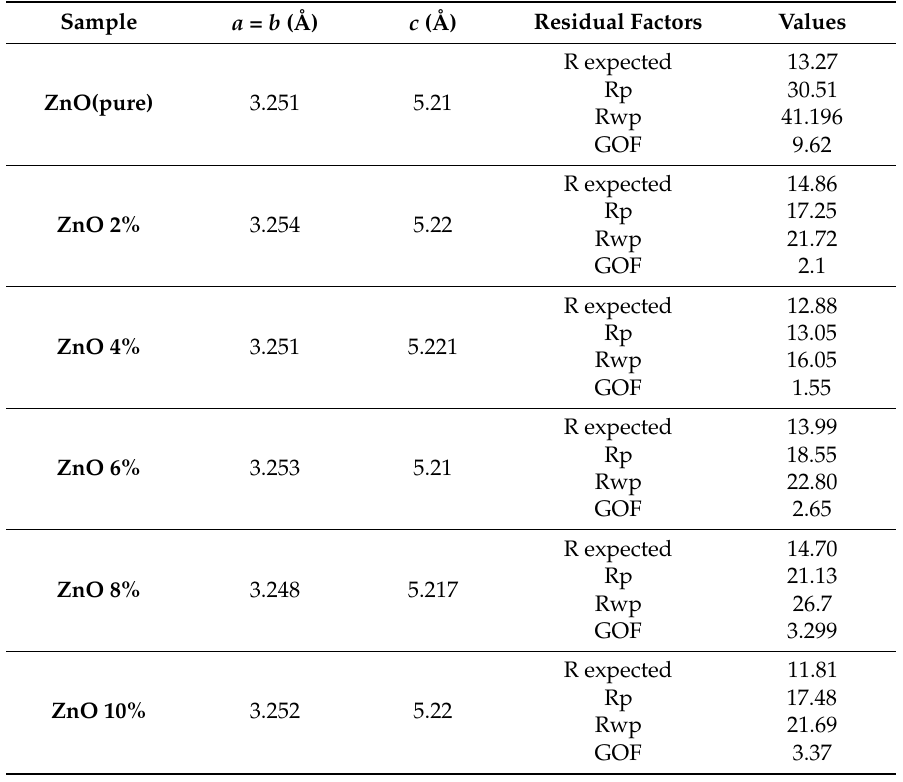
Table 2. Refined structure parameters for pure and 2–10% vanadium-doped ZnO